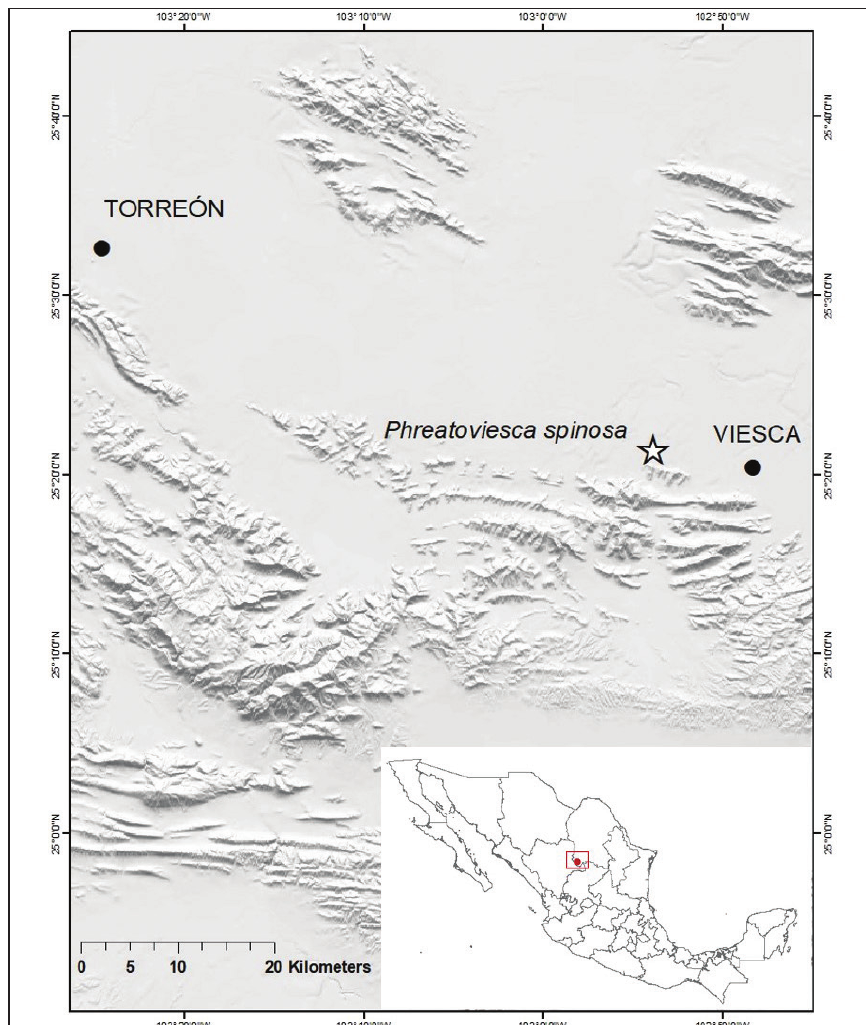
Figure 1. Map of the study area with localization of the sampling site near the town of Viesca, Coa- huila,